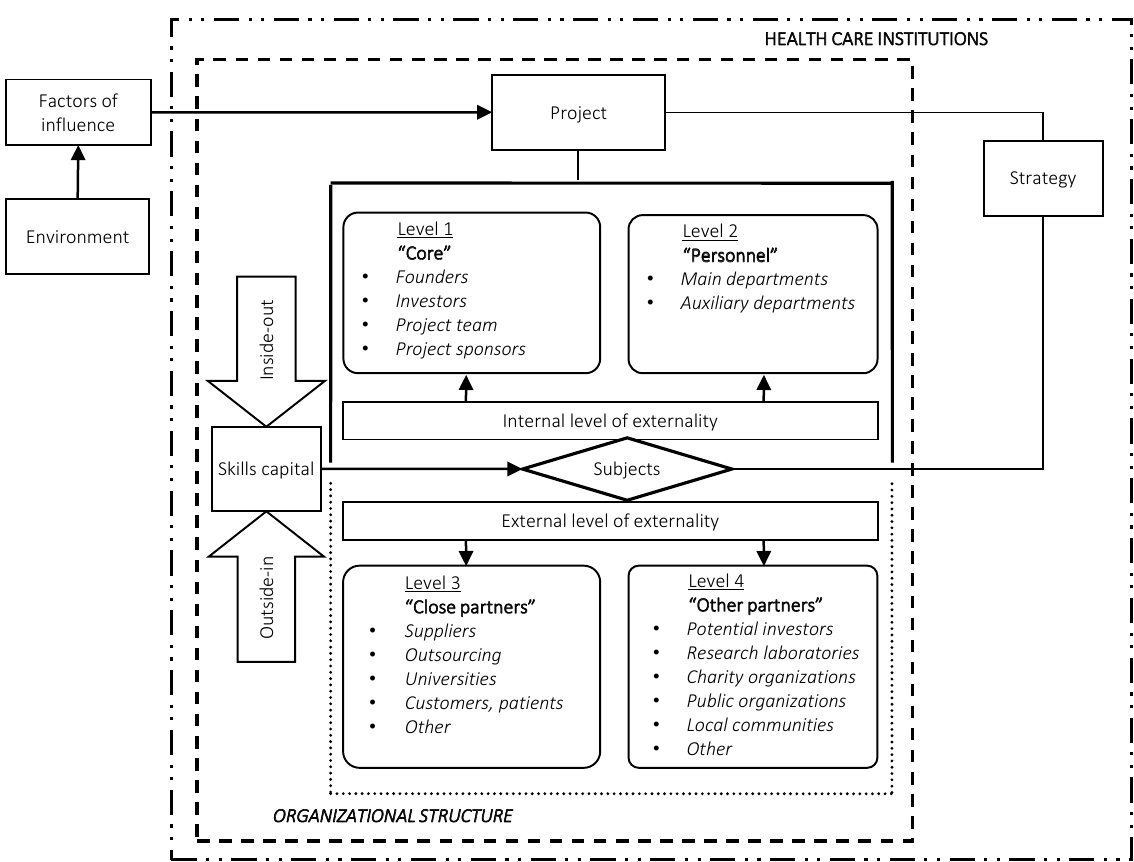
Figure 1. Conceptual model of organizational structure of a healthcare institution based on matching “factors of influence-skills” in the context of promoting Open